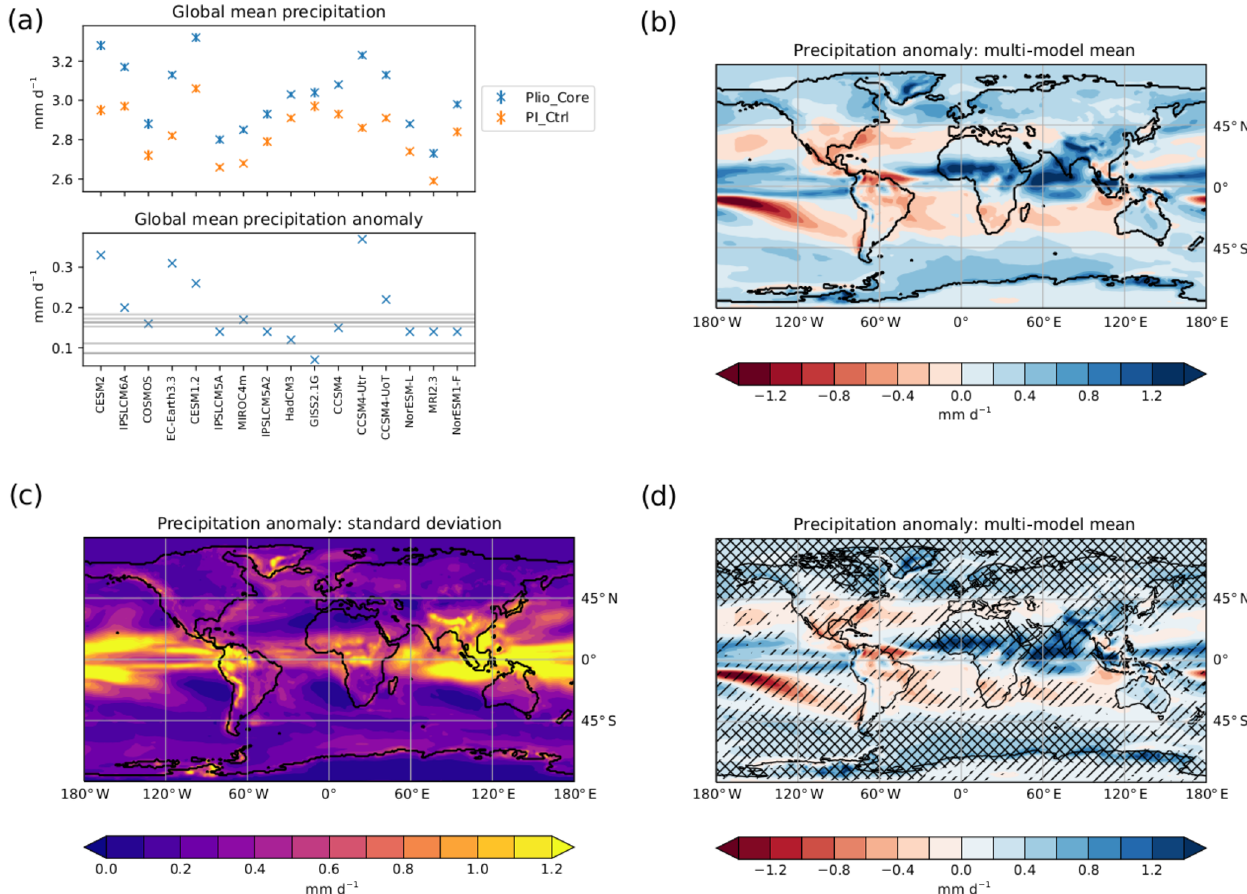
Figure 5. (a) Globally averaged precipitation for Plio Core and PI Ctrl from each model (upper panel) and the anomaly between them (lower panel). The horizontal grey lines in the lower panel show the values that were obtained from each individual PlioMIP1 model. (b) Multi- model mean Plio Core –PI Ctrl precipitation anomaly. (c) Standard deviation across the models for the Plio Core –PI Ctrl precipitation anomaly. (d) Plio Core –PI Ctrl precipitation anomaly. Regions which have at least 80% of the models agreeing on the sign of the change are marked with “ / ”. Regions where the ratio of the multi-model mean precipitation change to the PI Ctrl intermodel standard deviation is greater than 1 are marked with “ \